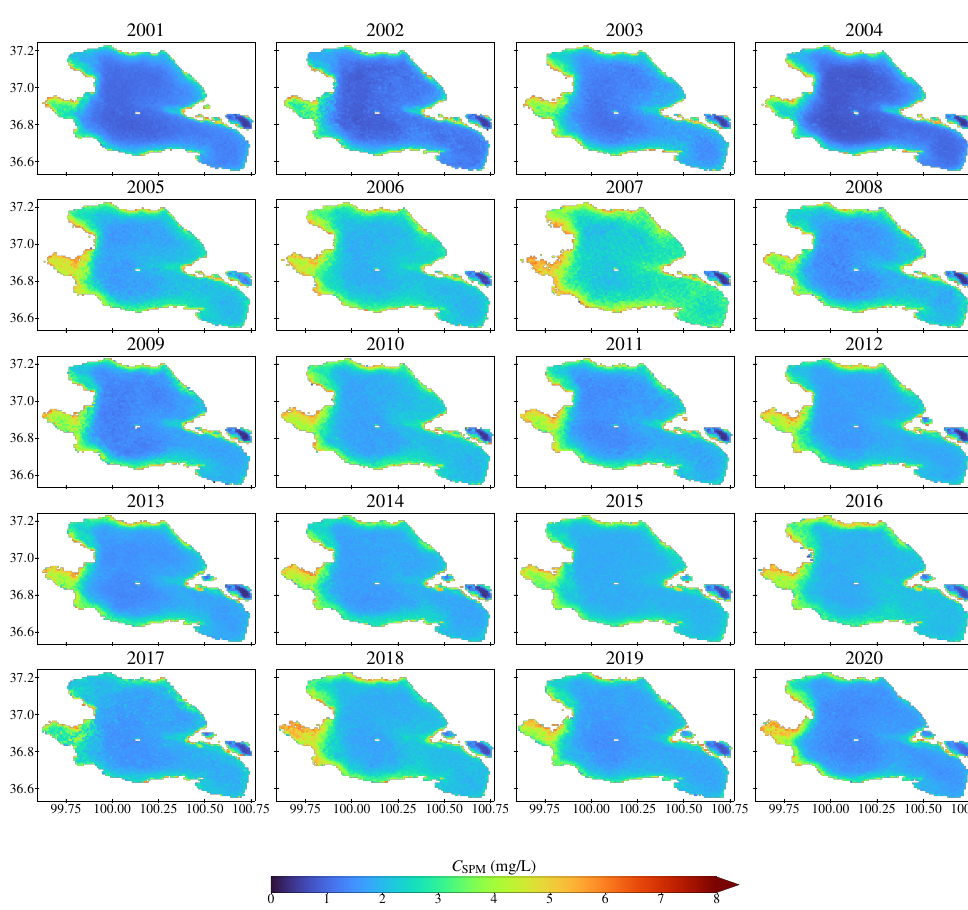
Figure 9. Spatial distribution of the annual mean C SPM from 2001 to 2020.